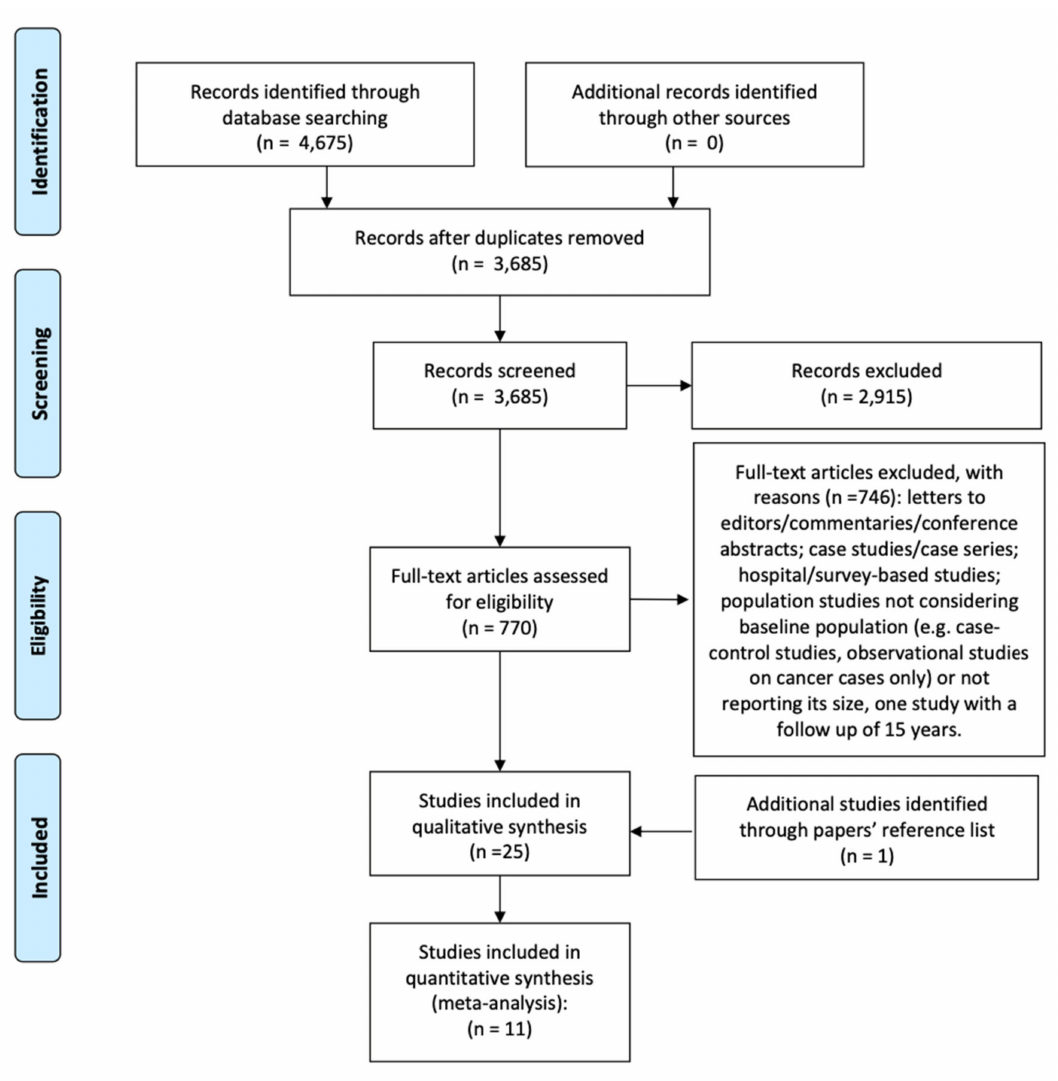
Figure 1. PRISMA flowchart summarizing the process for the identification of eligible